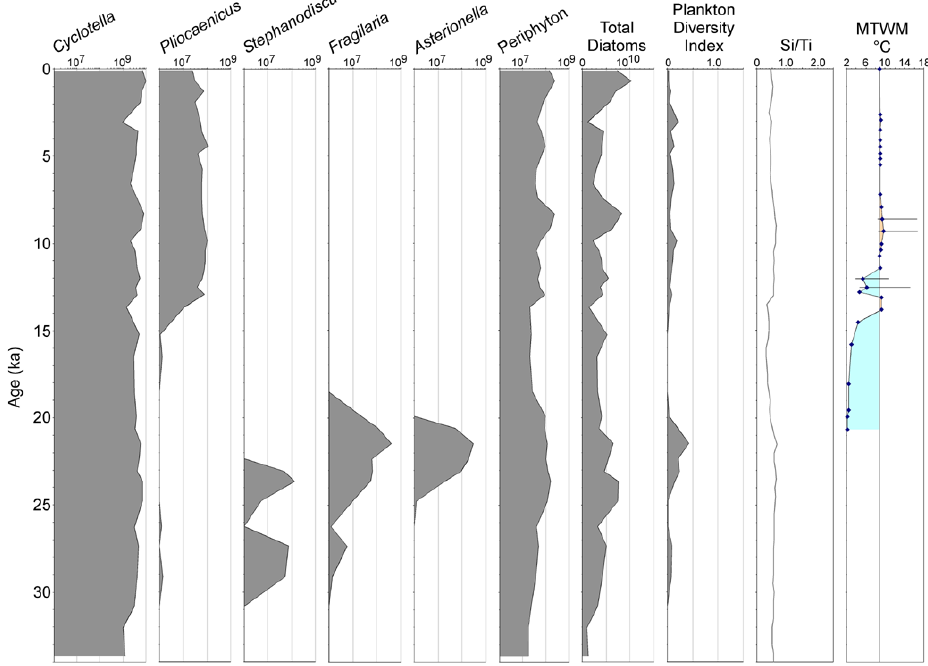
Fig. 3. Concentration (valves g − 1 ) of planktonic species, total periphyton, total diatoms, and plankton diversity (Shannon index) from 0– 34ka. For comparison, other El’gygytgyn climate proxies including Si/Ti measured by XRF core scanning and MTWM (mean temperature warmest month) derived from pollen data (best modern analog approach) (Melles et al., 2012). Other pollen data (Lozhkin et al., 2007) suggest continuation of a cold assemblage through the 20–34ka interval (not